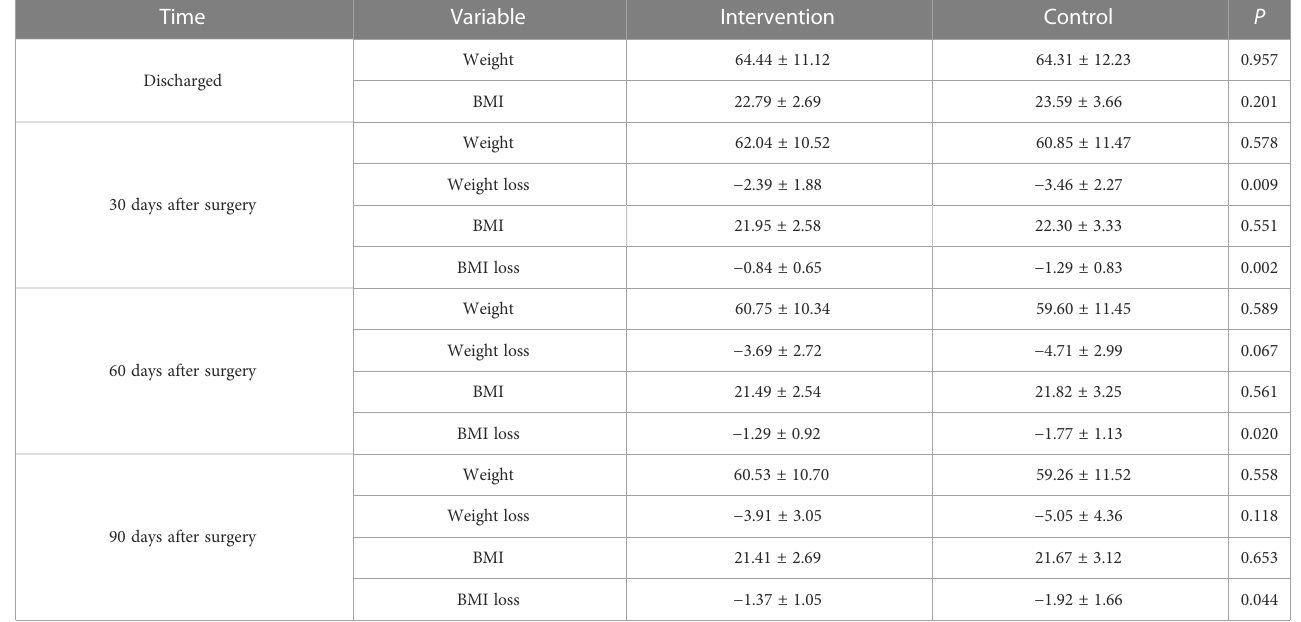
TABLE 3 Evaluation of patient weight and BMI.